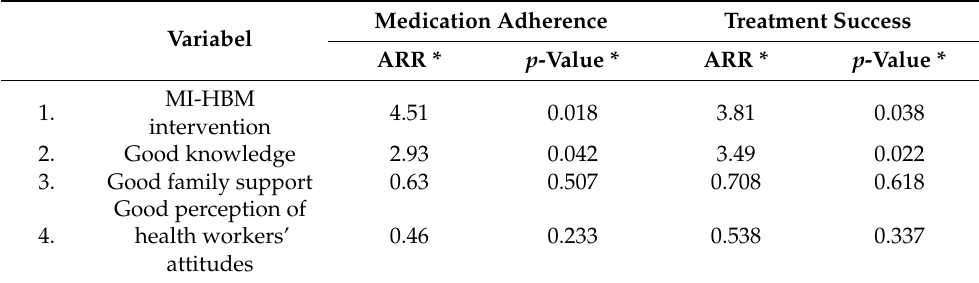
Table 3. Dominant factors that influence medication adherence and treatment